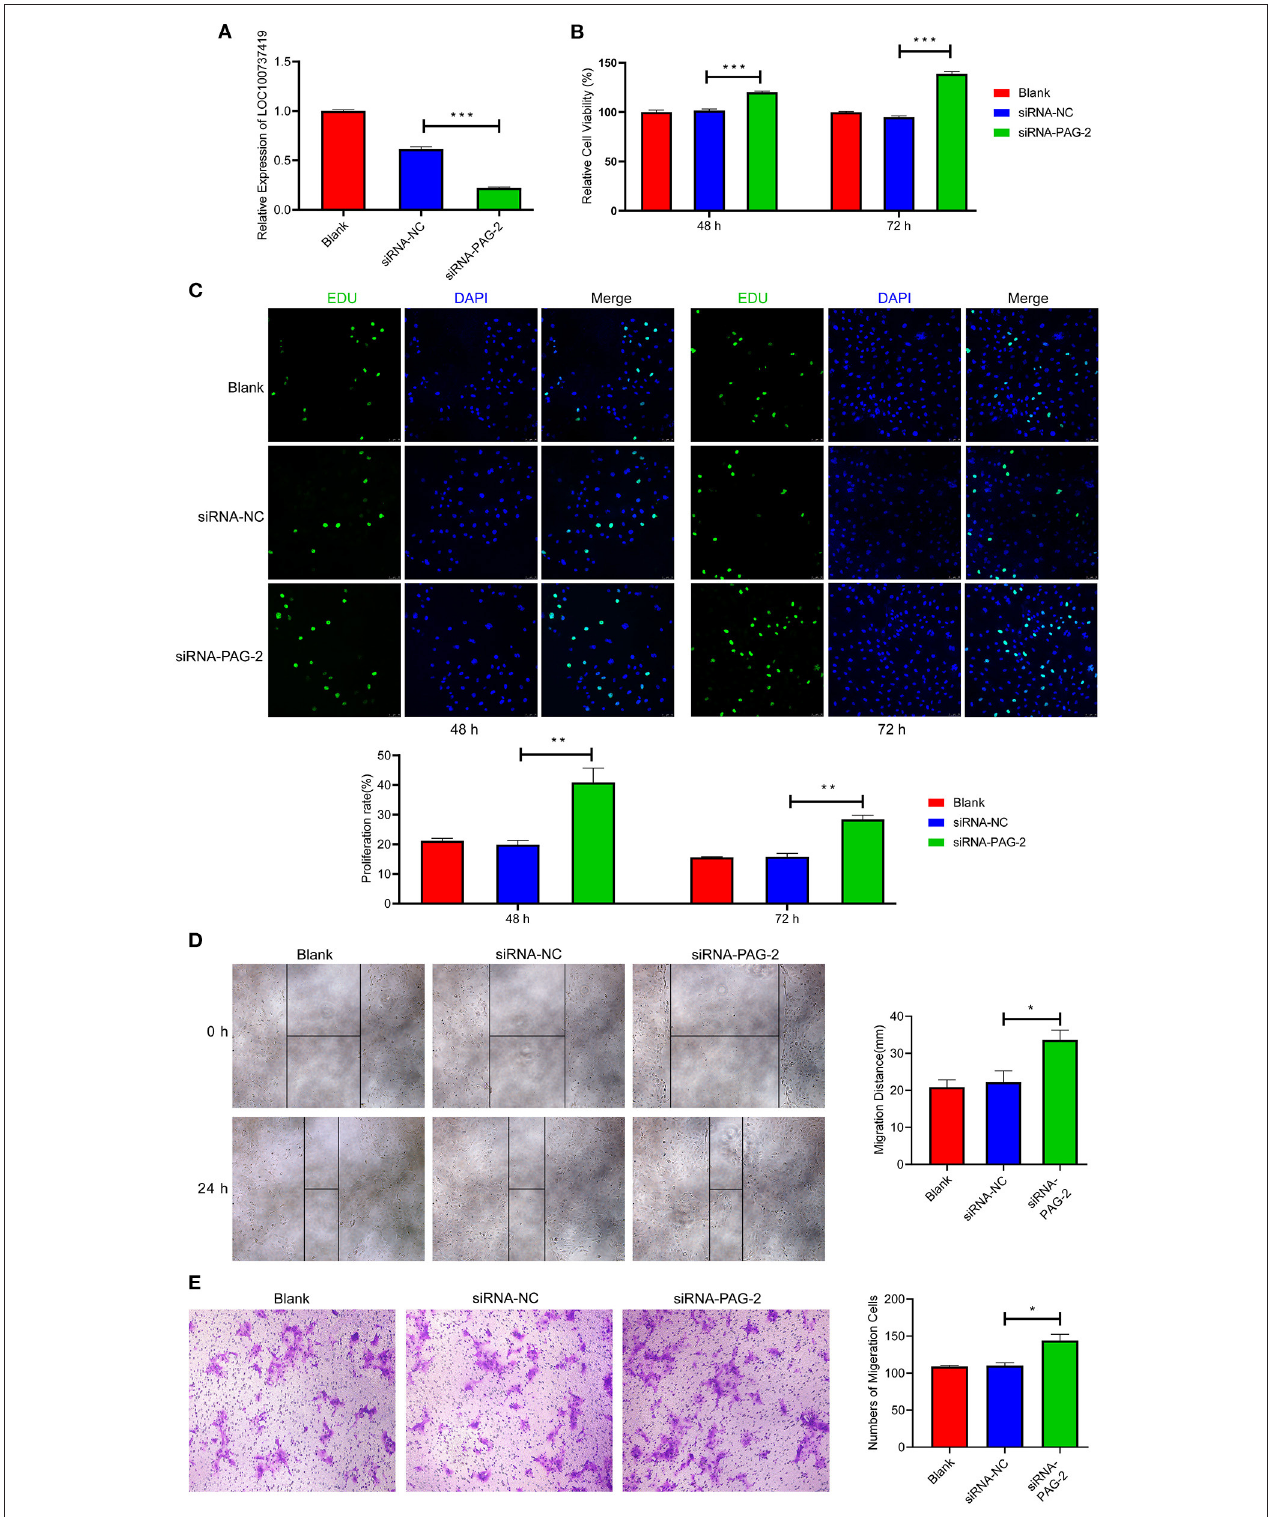
FIGURE 8 | Knockdown of PAG-2 promotes cell proliferation and migration in vitro . (A) Transfection efficiency of PAG-2 siRNA was determined by PCR. (B) The cell viability of PTr2 cells was applied by CCK-8 assay. (C) EDU staining assay was performed to determine the cell proliferation changes after PAG-2 knockdown. (D) Wound healing assay for the evaluation of migration of PTr2 cells. (E) Transwell migration assay showed that knockdown PAG-2 increased the cell numbers of migration. CCK8, Cell Counting Kit-8. Data are presented as mean ± SEM. * P < 0.05, ** P < 0.01, *** P < 0.001, Student’s t -test.